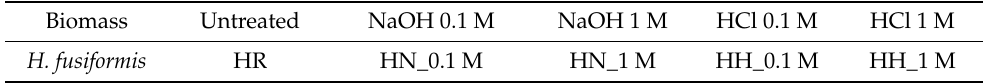
Table 1. Conditions for modifying H. fusiformis using HCl and NaOH. Biomass Untreated NaOH 0.1